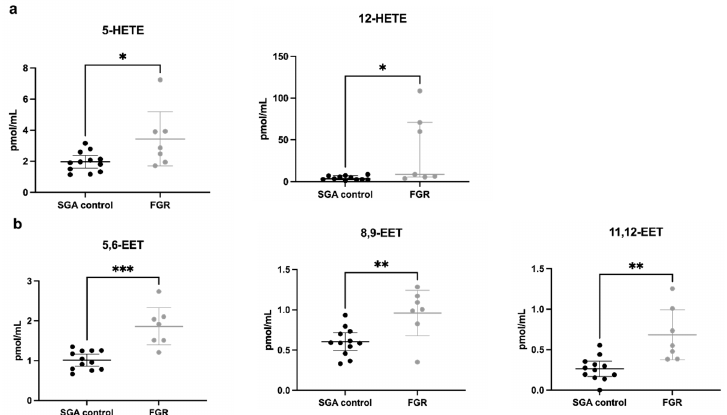
Figure 4. Eicosanoid concentrations (pmol/mL) in umbilical vein plasma. SGA control (n = 12) and FGR (n = 7) umbilical vein plasma concentrations of eicosanoids, arachidonic acid-derived lipid molecules. Concentrations of two families of eicosanoid molecules, ( a ) HETEs and ( b ) EETs were significantly elevated in FGR cord plasma. Concentrations are expressed as mean ± 95% CI (with the exception of 12-HETE, expressed as median ± IQR) in pmol/mL. * p < 0.05; ** p < 0.01; *** p < 0.001. Abbreviations: SGA, small for gestational age; FGR, fetal growth restriction; HETE, hydrox- yeicosatetraenoic acid; EET, epoxyeicosatrienoic acid; CI, confidence interval; IQR, interquartile range.